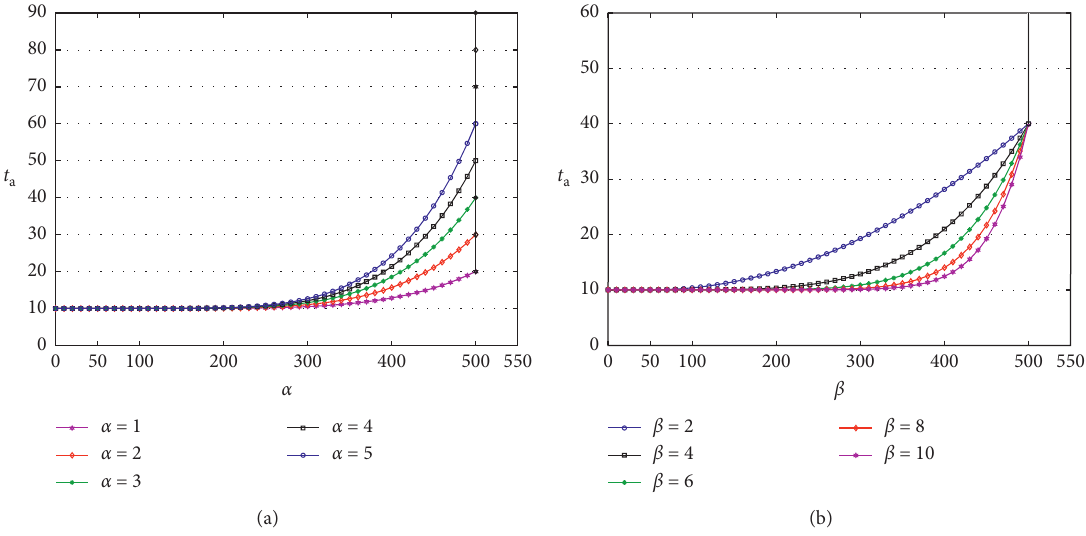
Figure 1: The impedance function t